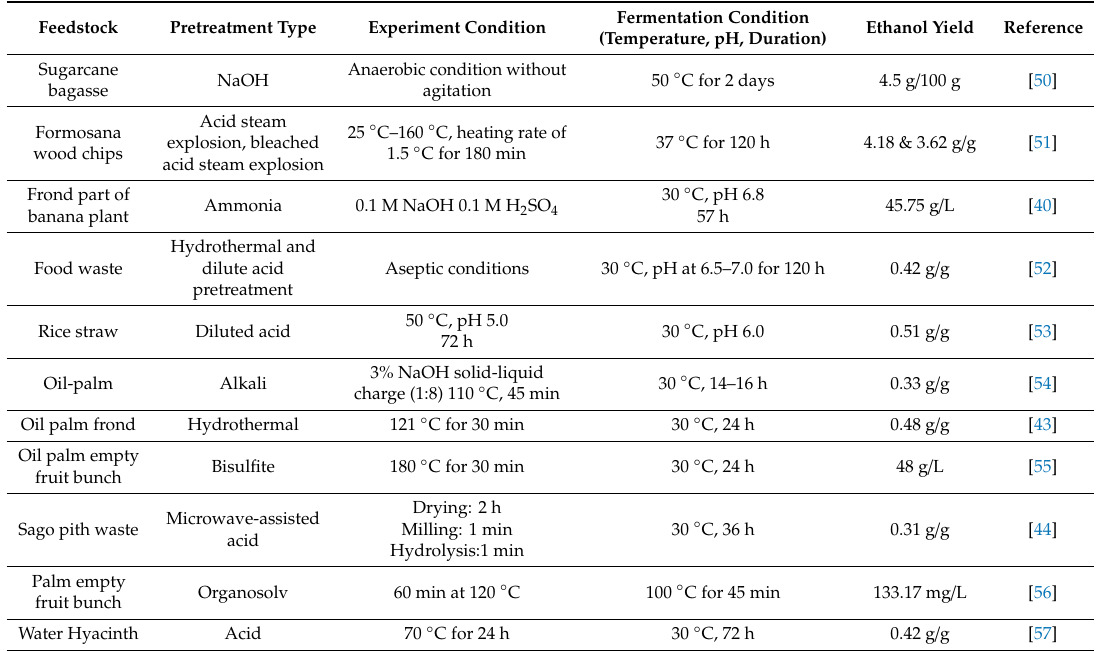
Table 2. Recent studies on bioethanol production from di ff erent sources in